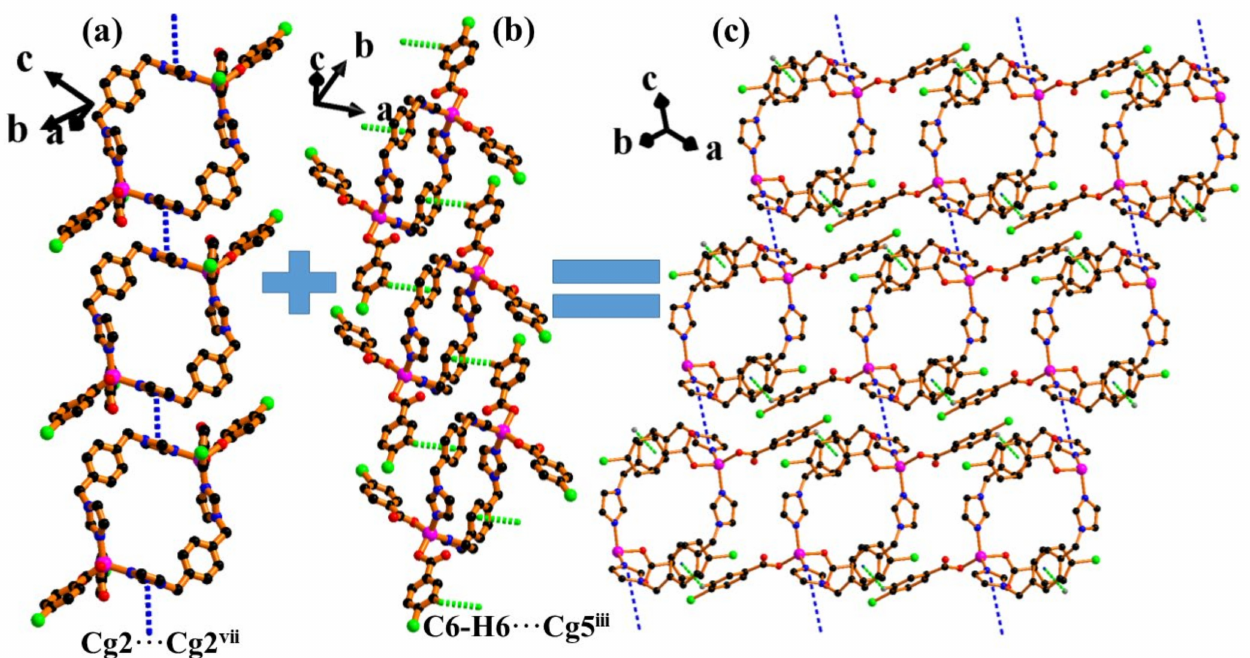
Figure 9. ( a ) The 1D chain constructed by π ··· π interactions in 2 (blue dash lines represent π ··· π interactions). ( b ) The 1D chain constructed by C–H ··· π interactions in 2 (bright green dash lines represent C–H ··· π interactions). ( c ) The 2D framework assembled with π ··· π and C–H ··· π interactions in 2 (blue dash lines represent π ··· π interactions, and bright green dash lines represent C–H ··· π